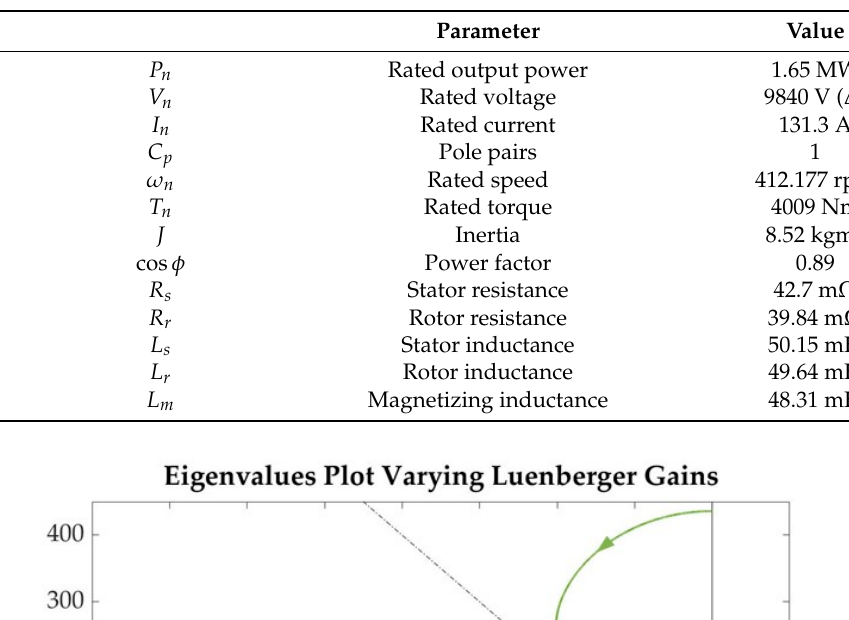
Table 1. Motor parameters.